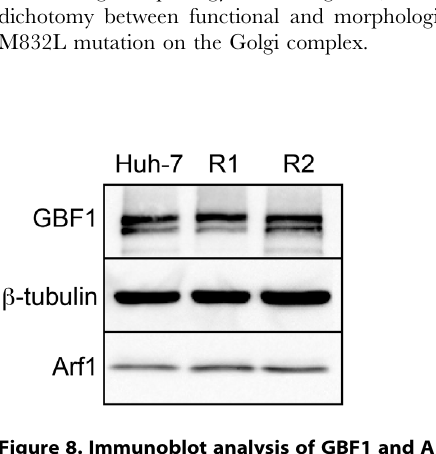
Figure 8. Immunoblot analysis of GBF1 and Arf1 expression in R1 and R2 cells. Equal amounts of lysates of the indicated cell lines were analyzed by immunoblotting for the expression of GBF1, Arf1 and b -tubulin.